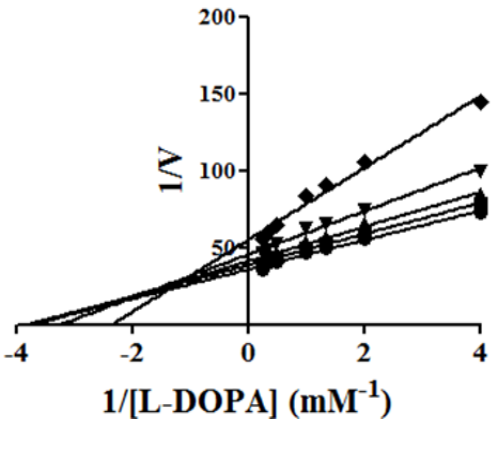
Figure 3. Lineweaver-Burk plot on the oxidation of L-DOPA by tyrosinase with INH1 (0 [ ● ]; 0.2 [ ■ ]; 0.4 [ ▲ ]; 0.8 [ ▼ ] and 1.6 [ ♦ ]